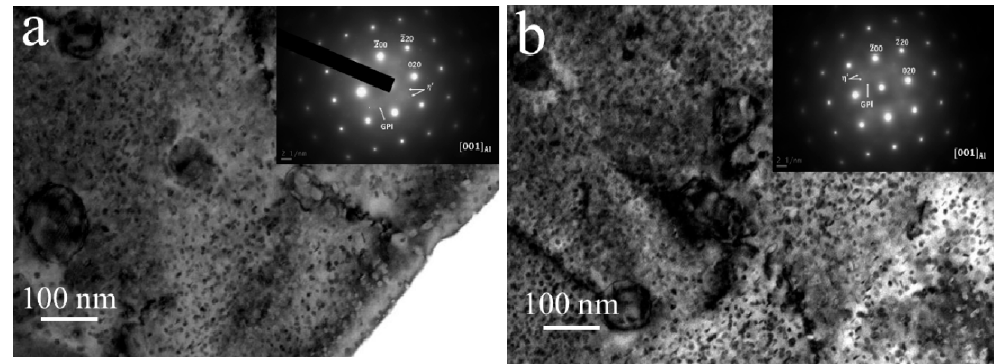
Figure 5. Bright field (BF) TEM images and diffraction patterns of the 7075 Al sheets in the [001] Al zone axis: ( a ) one-step aging for 16 h at 140 °C and ( b ) DA treatment (3 h at 120 °C and 3 h at 160 °C).